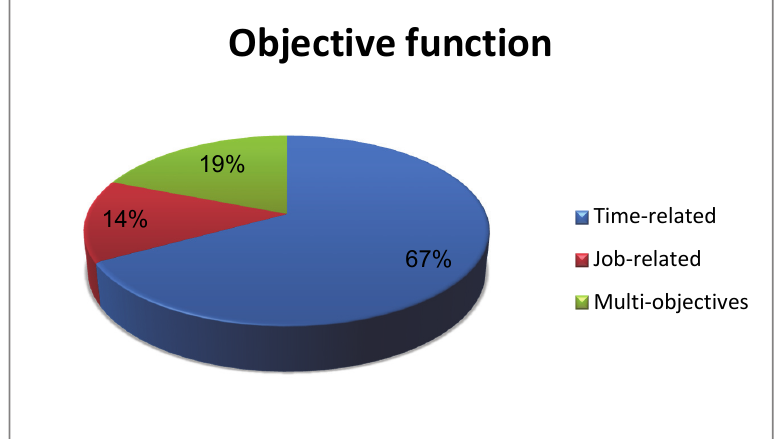
Fig. 2. Objectives functions used in flexible flow shop scheduling problem